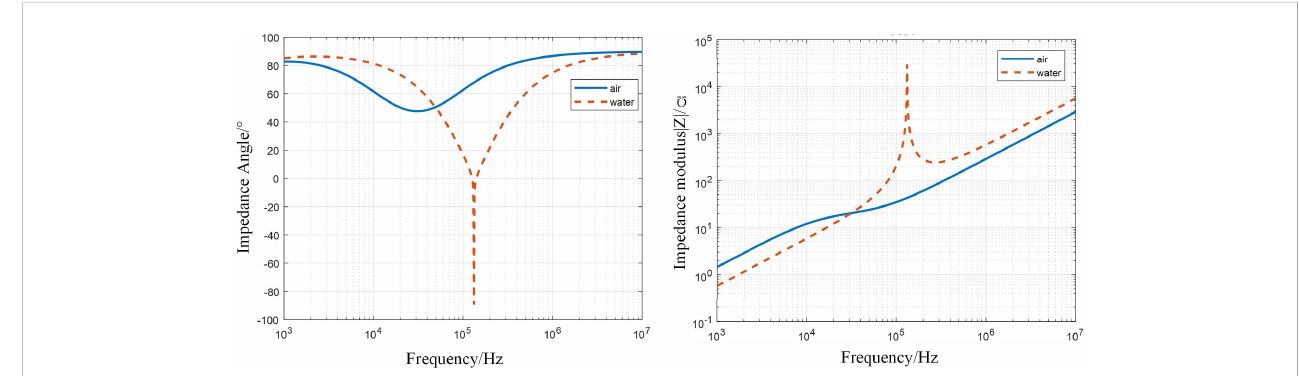
FIGURE 3 Frequency characteristics of the mutual inductance model in seawater and